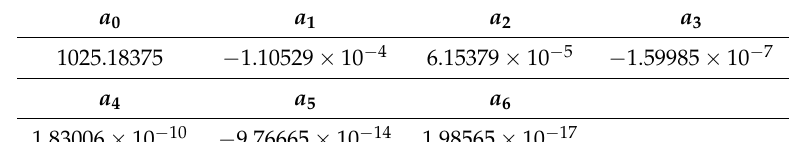
Table 2. The coefficient values for polynomial fitting of ρ h _ sw .